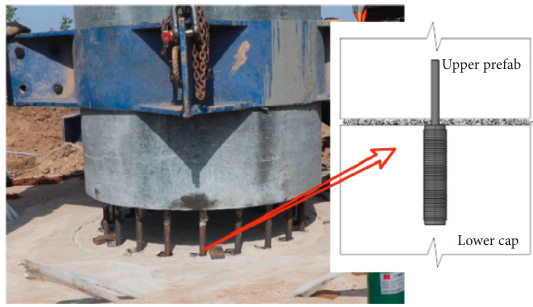
Figure 1: Joints structure diagram. Table 1: Grout performance evaluation table.